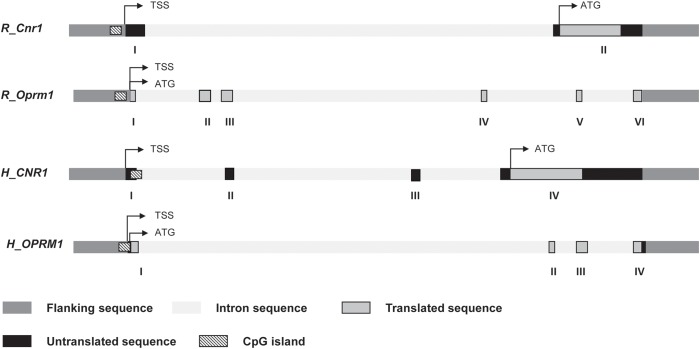
Schematic representation of rat and human Cnr1 and Oprm1 genes. Position of transcription start site (TSS), translation start code (ATG), exons and introns, CpG island are depicted. Details of the sequences under study for DNA methylation are shown in Supplementary Table S2.